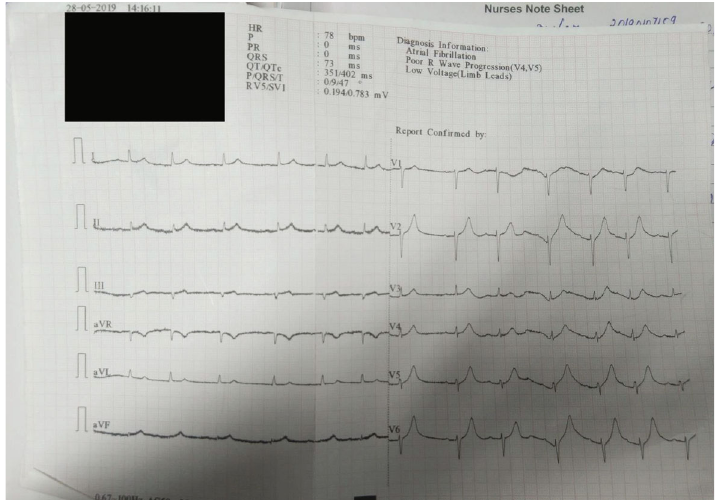
Figure 1: Electrocardiogram showed atrial fi brillation with poor progression of the R wave in leads V4 and V5 along with a QTc of 402ms.